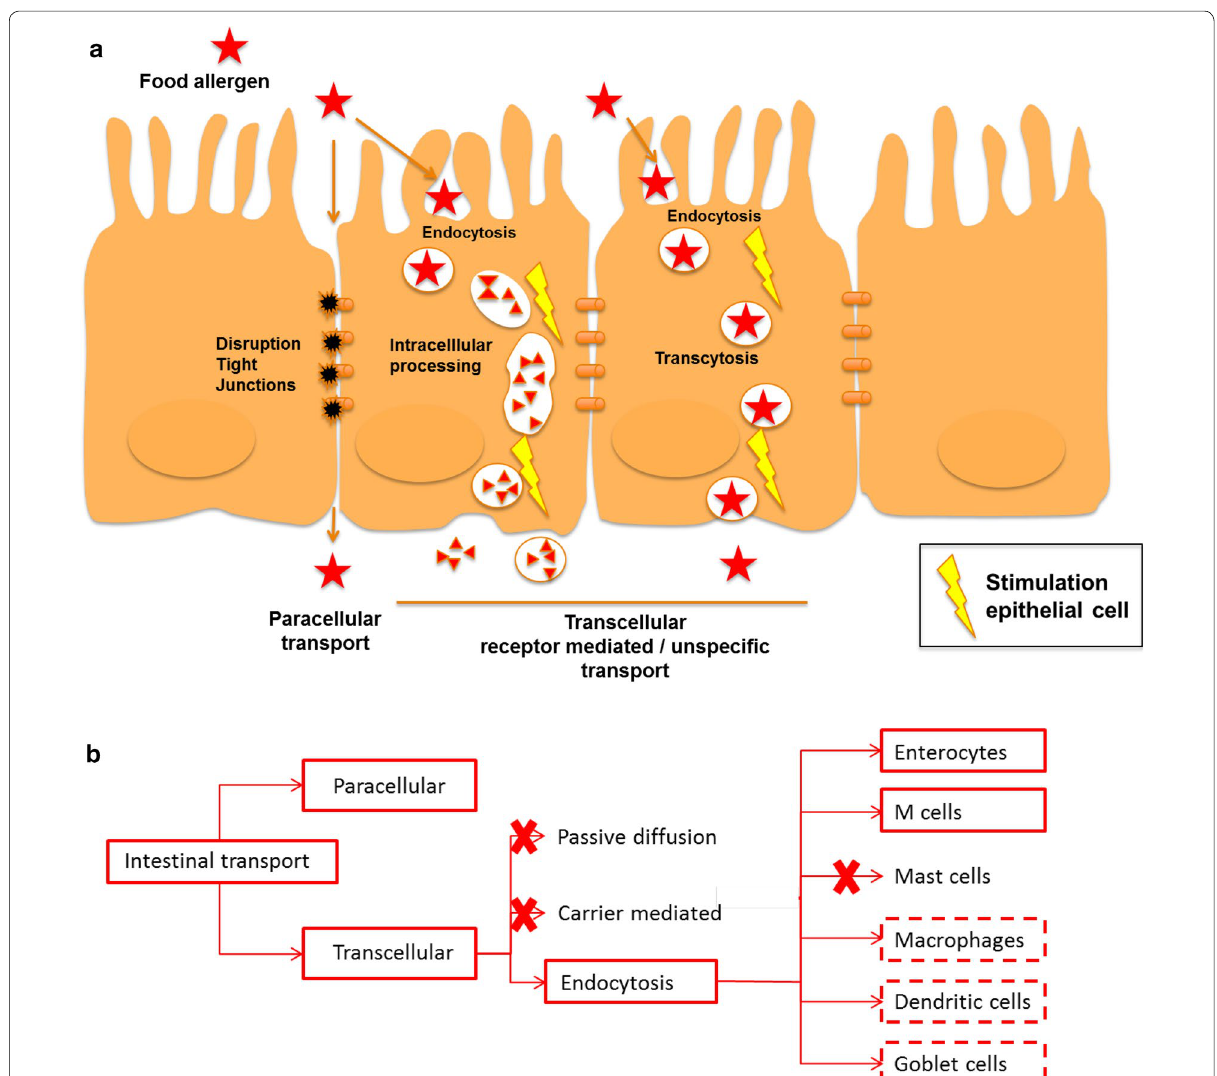
Fig. 2 Molecular initiating events (MIE) that initiate food sensitization. a Food allergen interaction with mucosal surfaces of the gut intestine may result in disruption of tight junctions, receptor mediated or unspecific transcellular transport of food allergens across the gut epithelium. These events can be the initiating events that results in the activation of epithelial and innate cells such as dendritic cells. b Mechanisms and cells involved in intestinal protein transport in non‑sensitized individuals. Solid boxes represent events with substantial evidence of being involved in food protein transport. Dashed boxes represent events that are possibly involved in food protein transport. Crosses indicate events and cell types of which there is no indication that they play a role in the transport of food proteins across the gut barrier in non‑sensitized